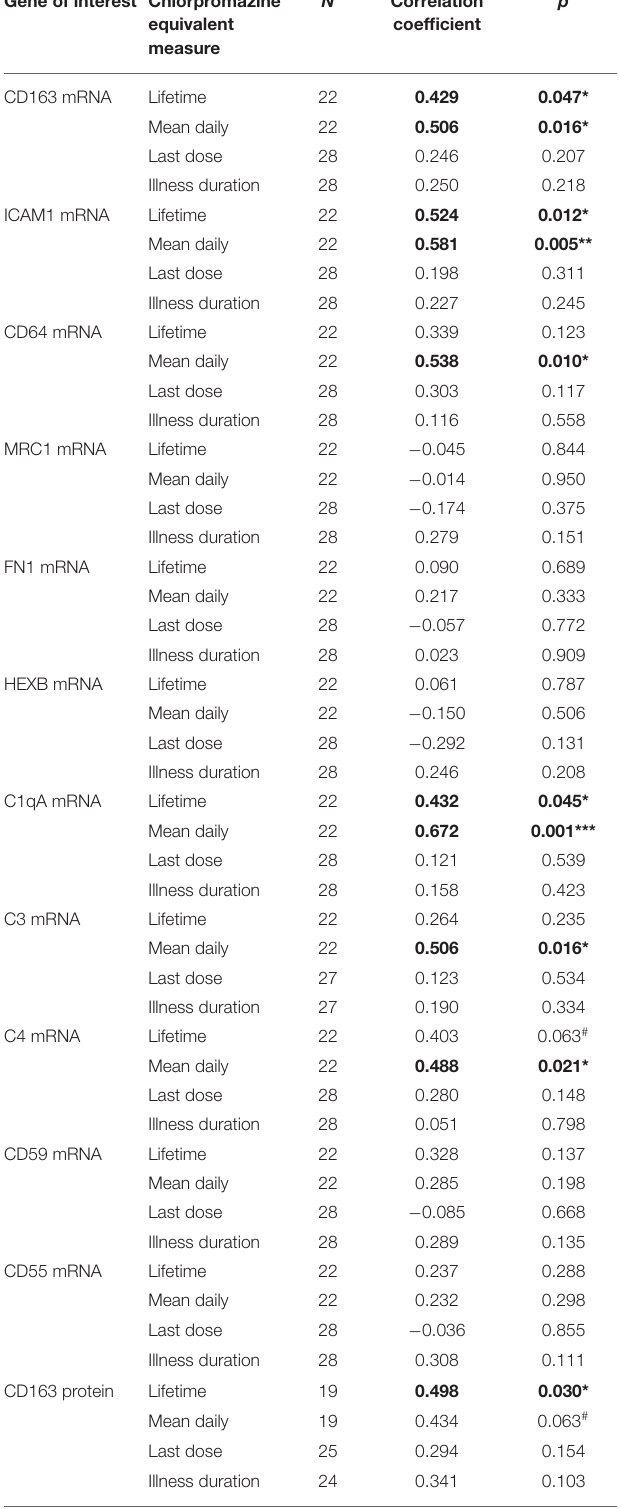
TABLE 2 | Correlations between mRNA transcripts, proteins of interest, chlorpromazine equivalents, and duration of illness (in schizophrenia cases only). N Correlation Gene of interest Chlorpromazine equivalent measure